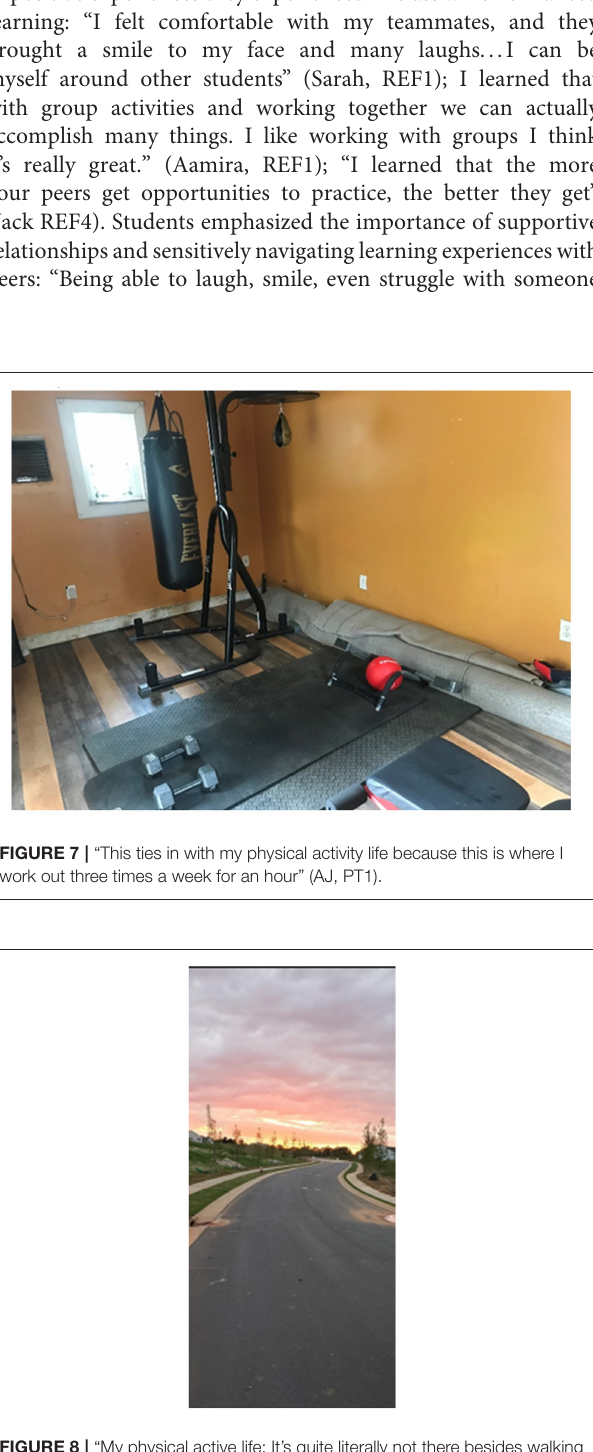
FIGURE 6 | “I play soccer outside in my backyard with my two brothers” (Khalid, PT1).